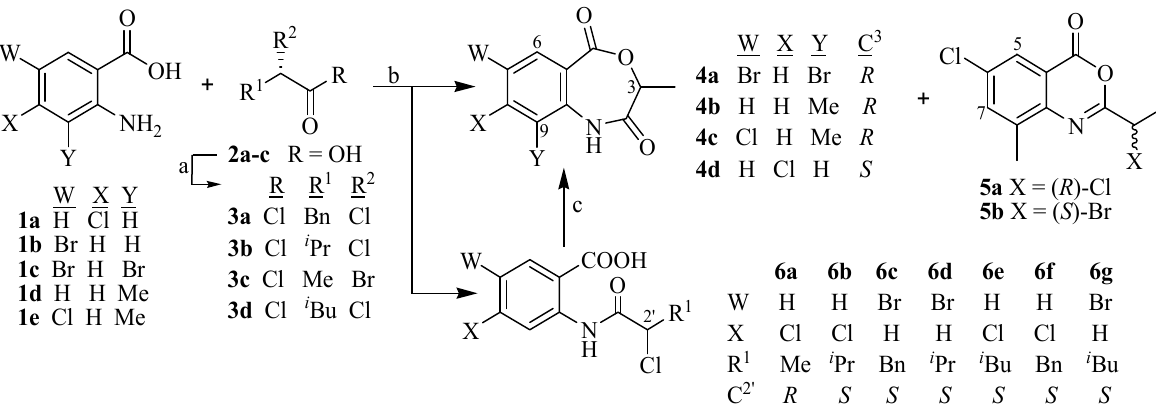
Reagents and Conditions : ( a ) SOCl